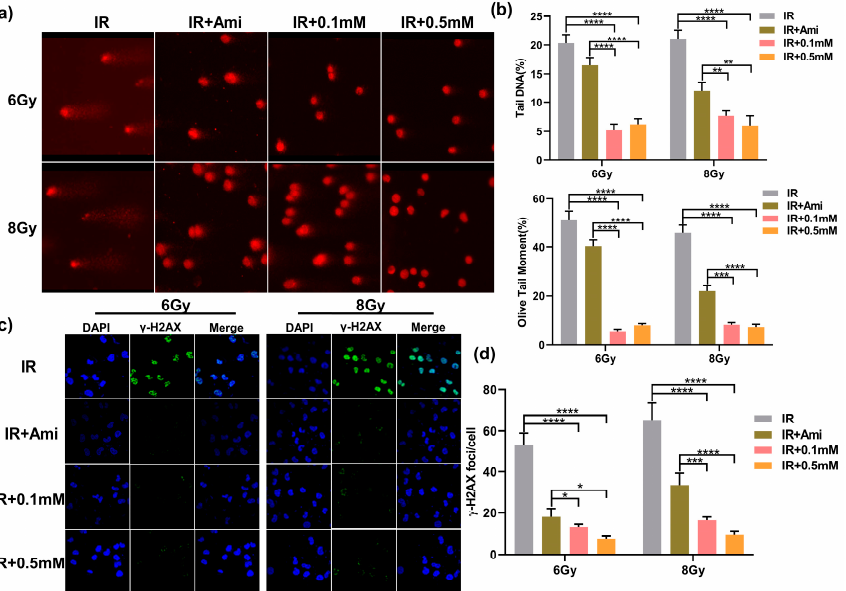
Figure 5. ( a ) Typical comet assay images of HIEC-6 cells treated with groups of IR, IR + Ami, IR + 0.1 mM, and IR + 0.5 mM after 6 and 8 Gy irradiation. ( b ) Quantitative analysis of olive tail moment and tail DNA from ( a ). Results are expressed as the mean ± SD of 50 replicates. ( c ) CLSM microscopy observation of γ -H2AX immunofluorescence of HIEC-6 cells treated with groups of IR, IR + Ami, IR + 0.1 mM, and IR + 0.5 mM after 6 and 8 Gy irradiation. ( d ) Quantitative analysis of γ -H2AX foci from Figure 5c. Results are expressed as the mean ± SD of 20 replicates.